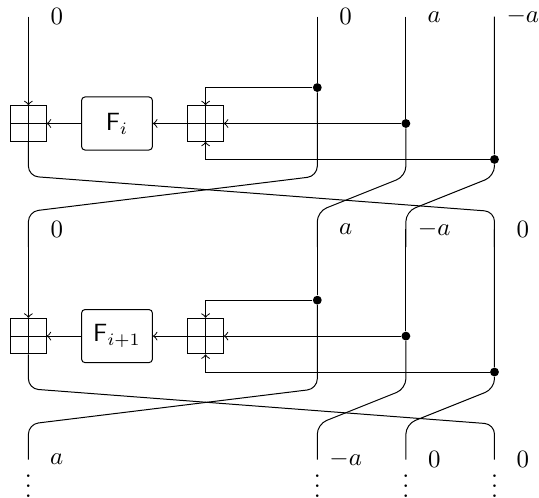
Figure 3: Prepending t − 2 rounds to the trail from Figure 2 with probability one. In characteristic two, the minus signs may be